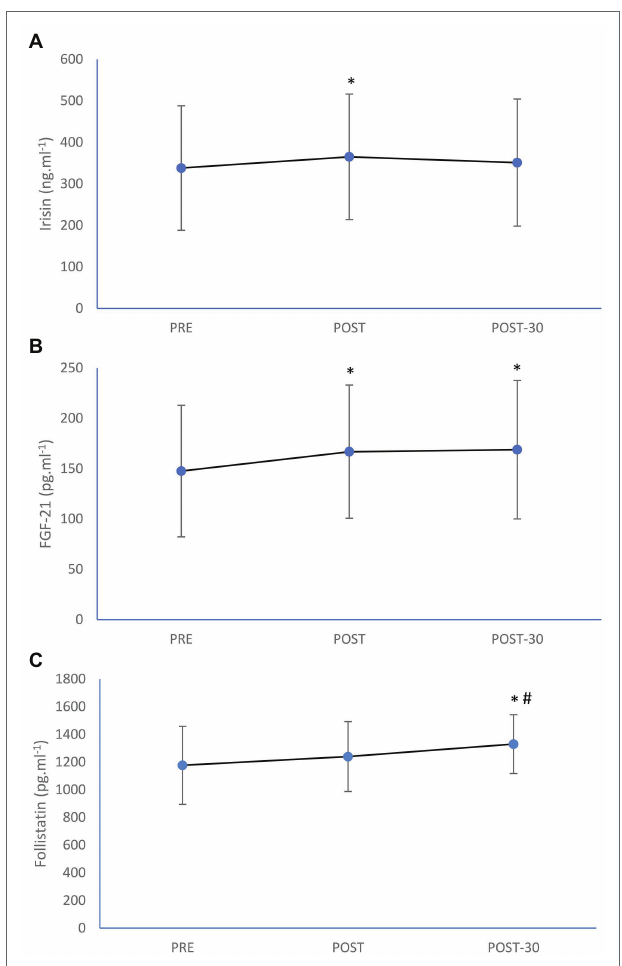
FIGURE 1 | Mean (±SD) irisin (A) , fibroplast growth factor-21 (FGF-21; B ), and follistatin (C) concentrations before (PRE), immediately after (POST), and after 30-min rest (POST-30) of 1-h of prolonged rowing exercise in female rowers. * Significantly different from PRE; p < 0.05. # Significantly different from POST; p <